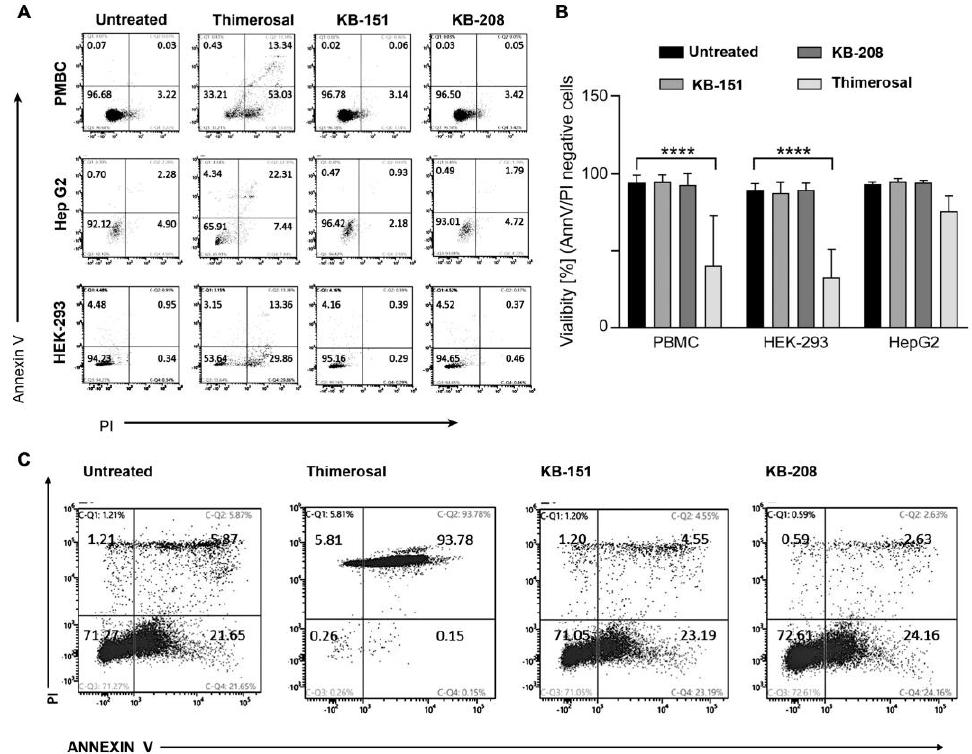
Figure 8. Apoptosis assay for PBMC, Hep G2, and HEK-293 all treated with KB-151 and KB-208 at 250 µ M concentration for 1 h. ( A ) Representative example of treatments ( B ) Summary of three independent experiments (**** p < 0.0001). ( C ) PBMC treated with KB-151 and KB-208 at 250 µ M concentration for 24